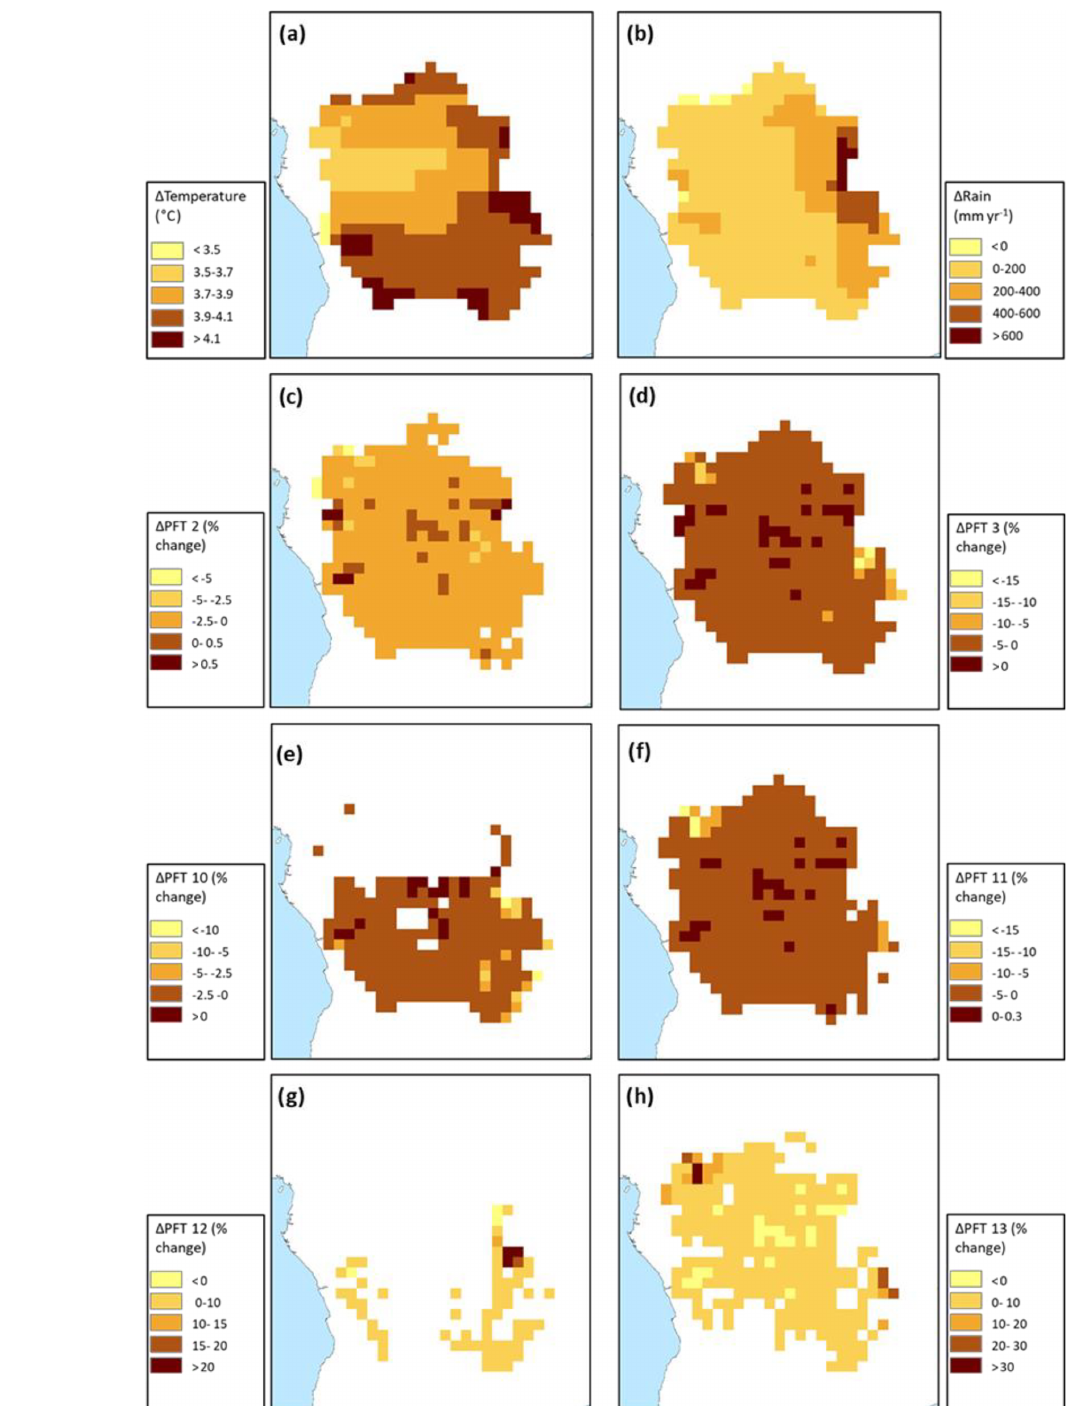
Figure A2. Change ( (cid:49) , 2099 minus 1861) in the spatial distribution of the principal climate and land use drivers across the Congo Basin; (a) mean annual temperature ( ◦ C), (b) mean annual rainfall (mmyr − 1 ), and (c–h) mean annual maximum vegetated fraction for PFTs 2, 3, 10, 11, 12, and 13. All are at a resolution of 1 ◦